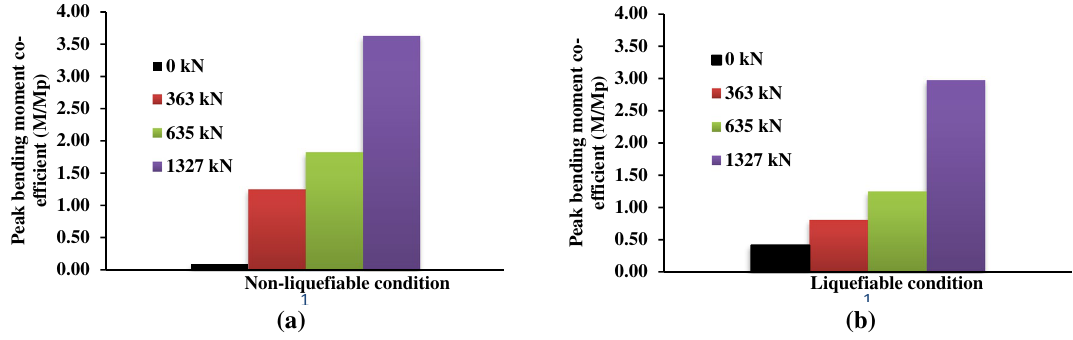
Fig. 19 Comparison of peak bending moment co-efficient of pile for a non-liquefiable and b liquefiable soil condition of RCD soil when sub- jected to scaled IMV